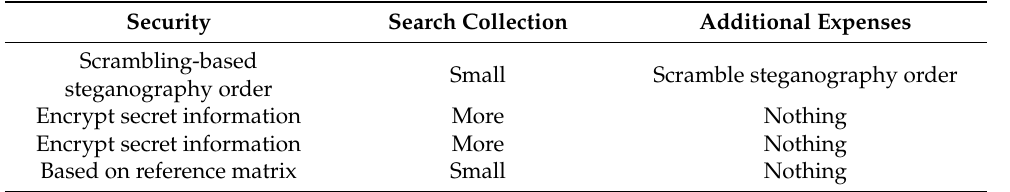
Table 5. Security of image coding